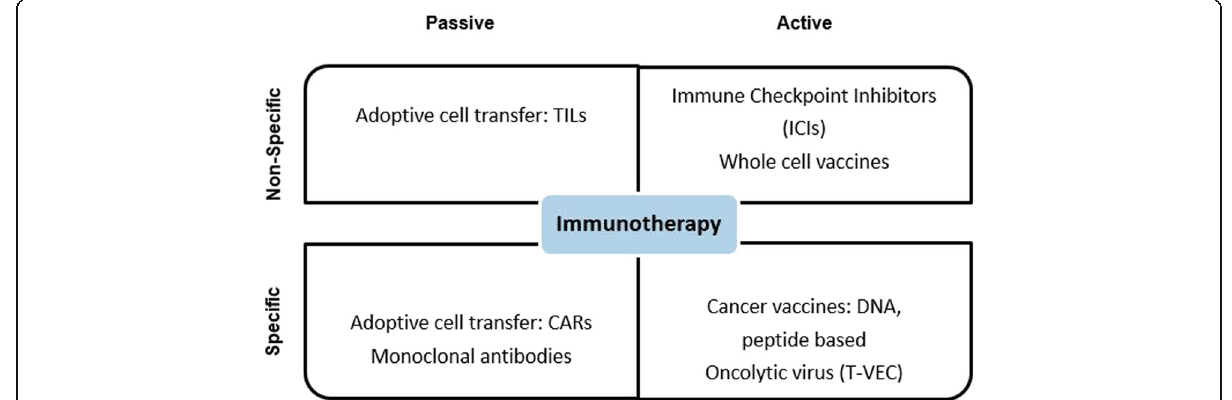
Fig. 1 Different approaches of immunotherapy. CAR Chimeric antigen receptor, DNA Deoxyribonucleic acid, TILs Tumour-infiltrating lymphocytes, T-VEC Talimogene